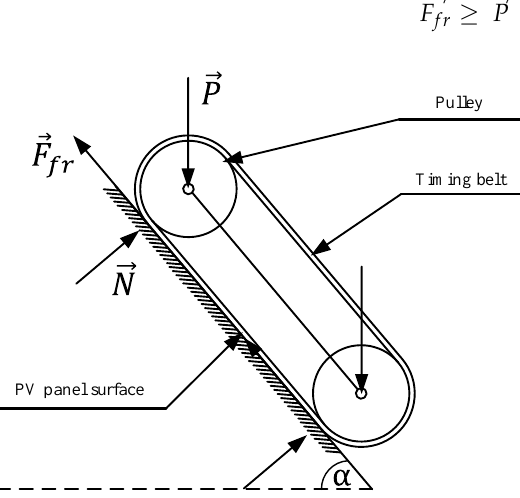
Figure 1. Force analysis in the no-slip state and zero